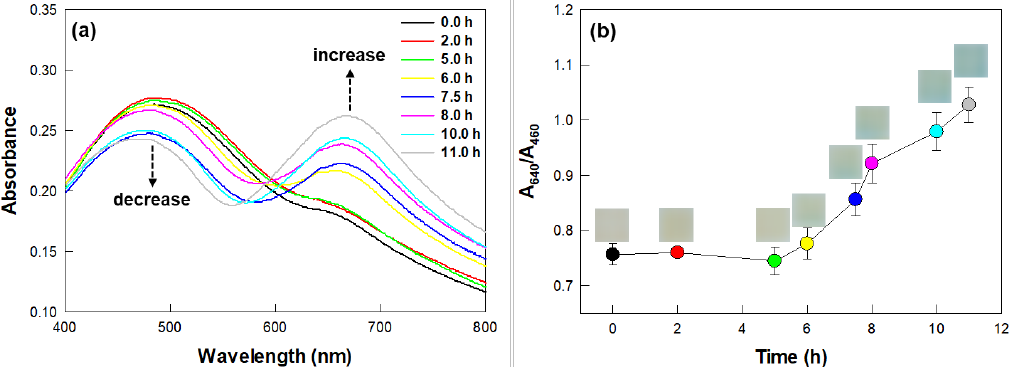
Figure 3. Colorimetric detection of ureolytic activity in Klebsiella pneumoniae ( K. pneumoniae ). ( a ) Ab- sorbance spectra and ( b ) A 640 /A 460 values of the colorimetric film sensors exposed to K. pneumoniae for the indicated incubation times. Symbols and error bars indicate the mean and standard deviations of biological triplicates. Insets show photographs of film sensors at each incubation time.